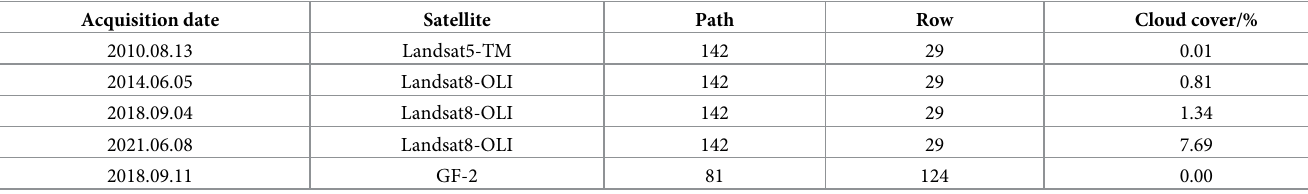
Table 1. Specifications of the satellite data used in this